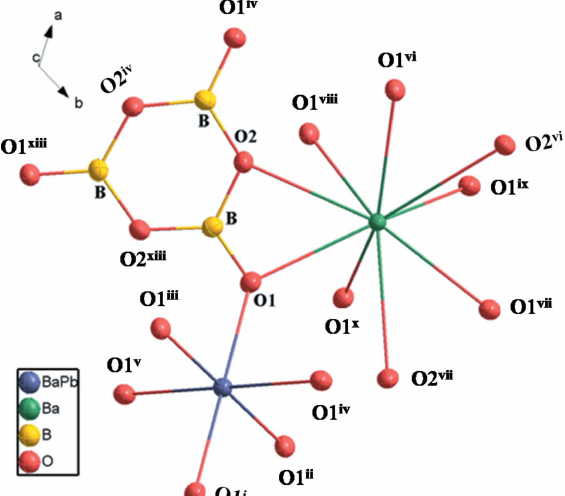
Figure 1 The principal building units in the crystal structure of the title compound. (iv) x (cid:2) y , x , (cid:2) z ; (v) (cid:2) x + y , (cid:2) x , z ; (vi) (cid:2) y + 1, x (cid:2) y , z ; (vii) (cid:2) x + y + 1, (cid:2) x + 1, z ; (viii) y +